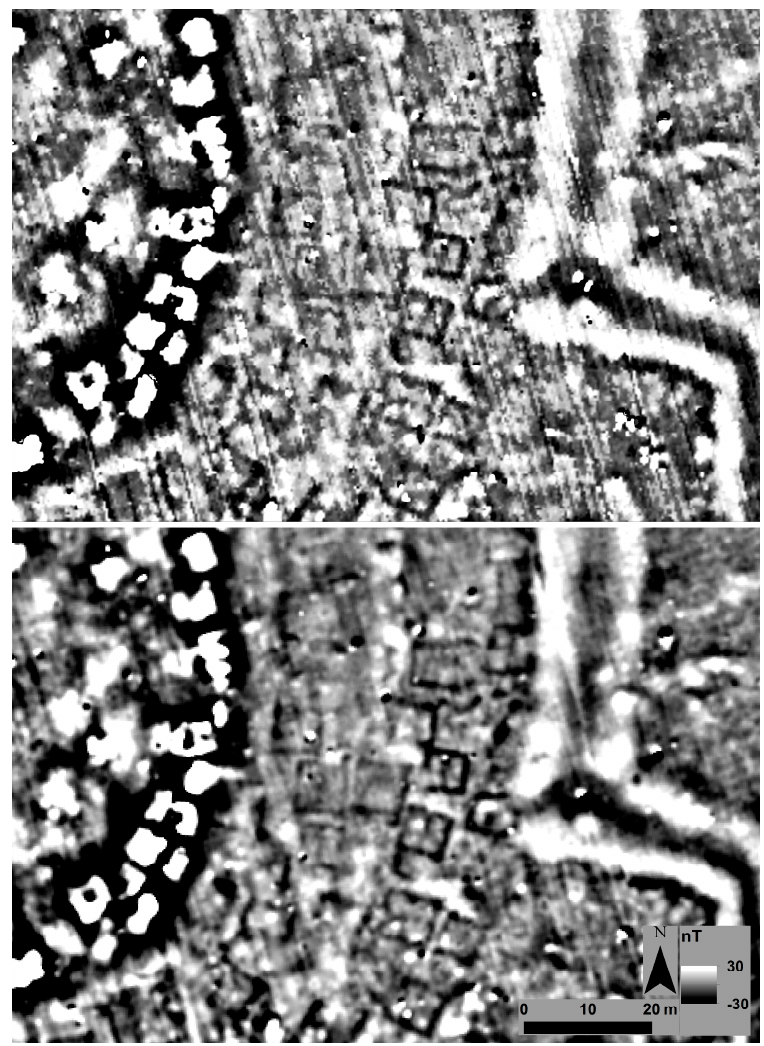
Figure 4. The raw data ( above ) is imported from the SENSYS software in GeoTIFF format and displayed in a Geographic Information System (GIS). The processed data ( below ) shows drastic improvements over the original dataset. The data is an excerpt from Magoula Almyriotiki (see Section 5.1).